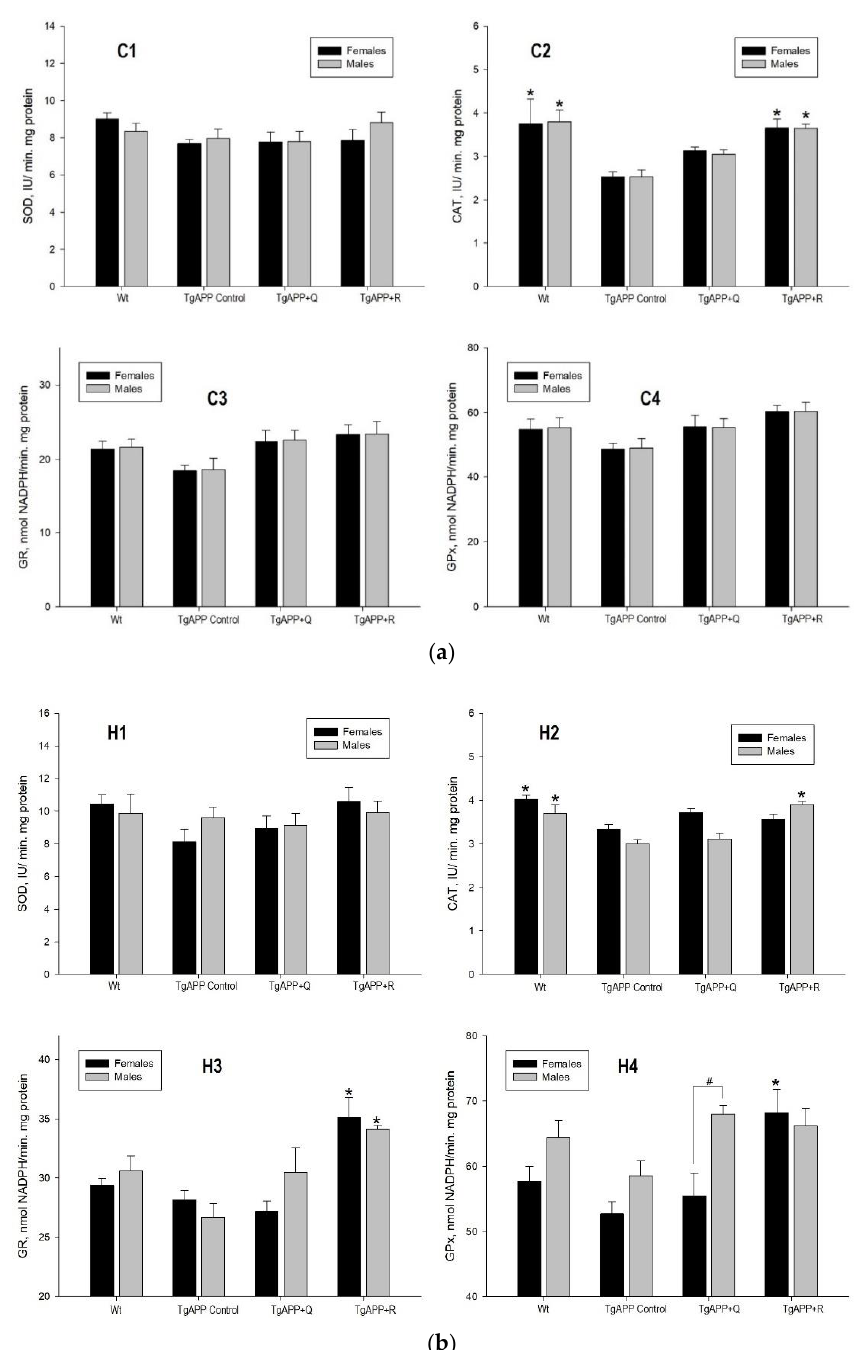
Figure 4. ( a ). Effect of quercetin (Q) and rutin (R) on the enzymatic activities of SOD (C1), CAT (C2), GR (C3), and GPx (C4) in Cortex (C). (1) WT; (2) TgAPP control; (3) TgAPP + Q; (4) TgAPP +